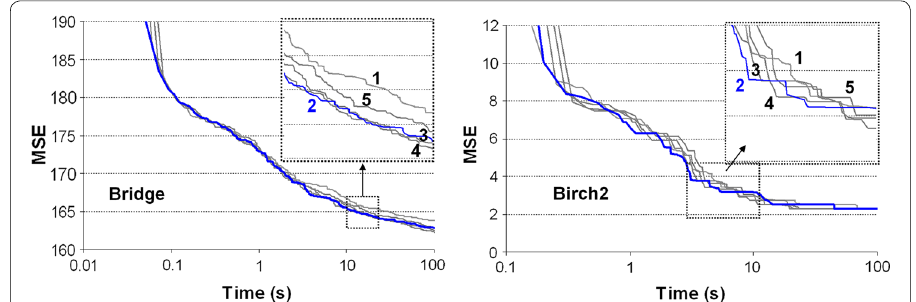
Fig. 14 Effect of the number of k-means iterations applied within RS. The value 2 is slightly better choice but the exact value is not critical. Only when iterated very long, high number of k-means iterations can become more beneficial with the image datasets. When running 45 min with Bridge, iterating k-means until convergence improved the SSE-value from 161.38 to 160.89 (improvement of